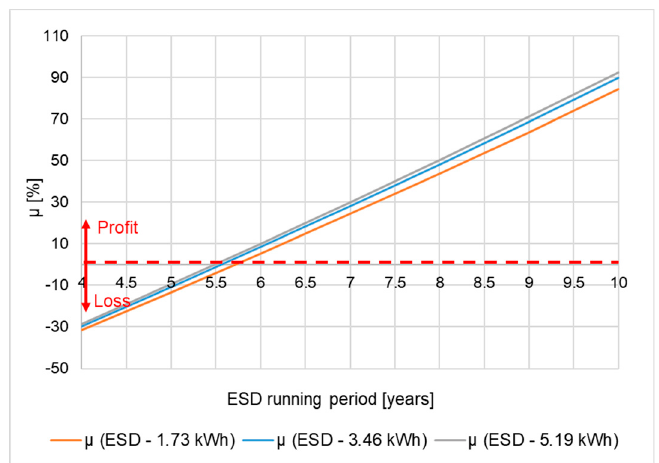
Figure 11. Economic efficiency optimization parameter - higher price for the energy and profits form reduction of C0 2 emission included.